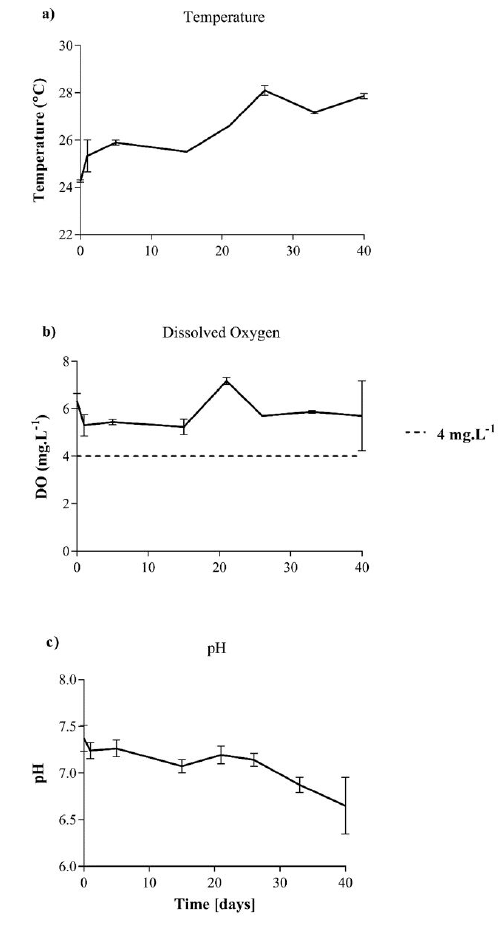
Figure 3. Changes in water temperature (a), dissolved oxygen (b) and pH (c).